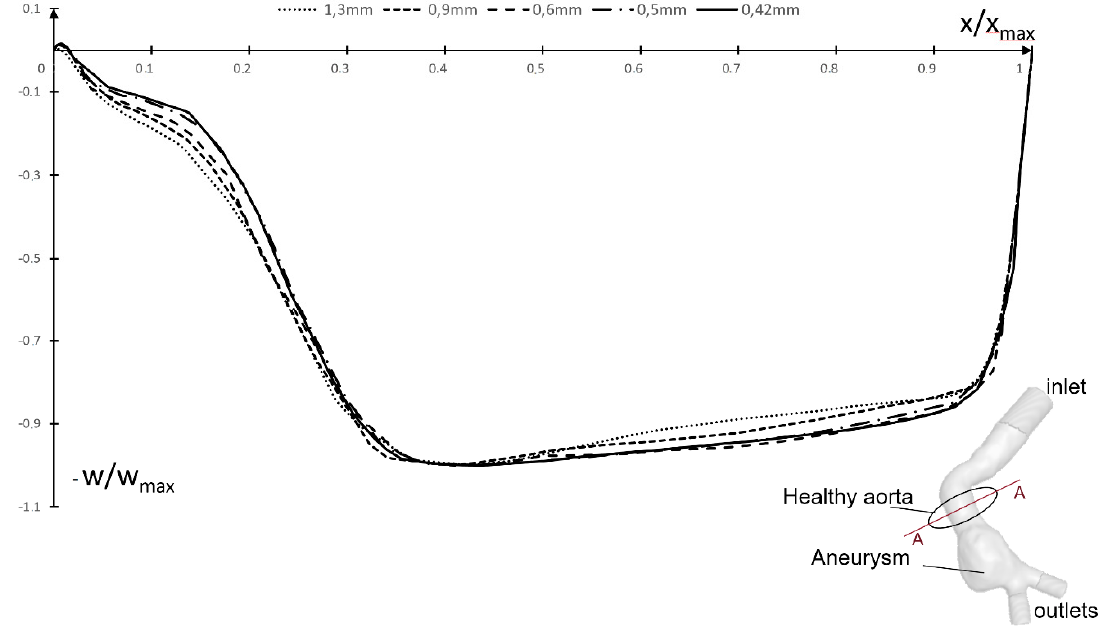
Figure 4. Dimensionless w-velocity at systolic peak instant ( t = 0.25 s), plotted in section A-A passing from the healthy aorta to the aneurysm, for different sizes of the mesh element: 1.3 mm, 0.9 mm, 0.6 mm, 0.5 mm, and 0.42 mm.